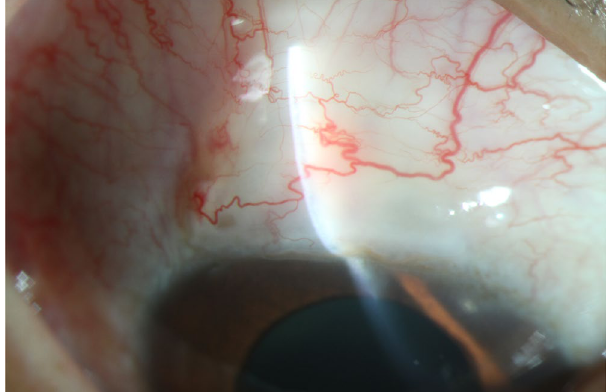
Figure 1. The Slit lamp photo of the filtering bleb after trabeculectomy in patients with neovascular glaucoma. The filtering bleb is present, the cornea is clear, and the neovascularisation of the iris is regressed.